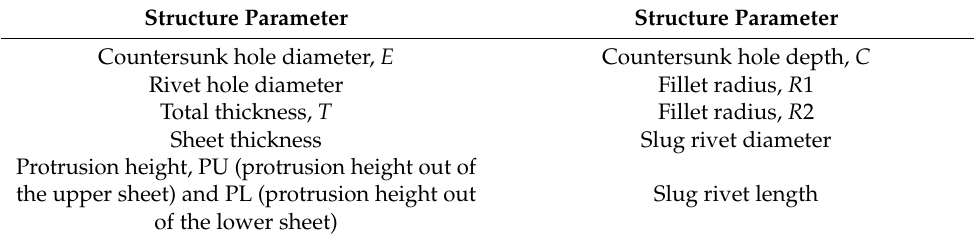
Table 1. The main structure riveting parameter of a riveted lap joint.